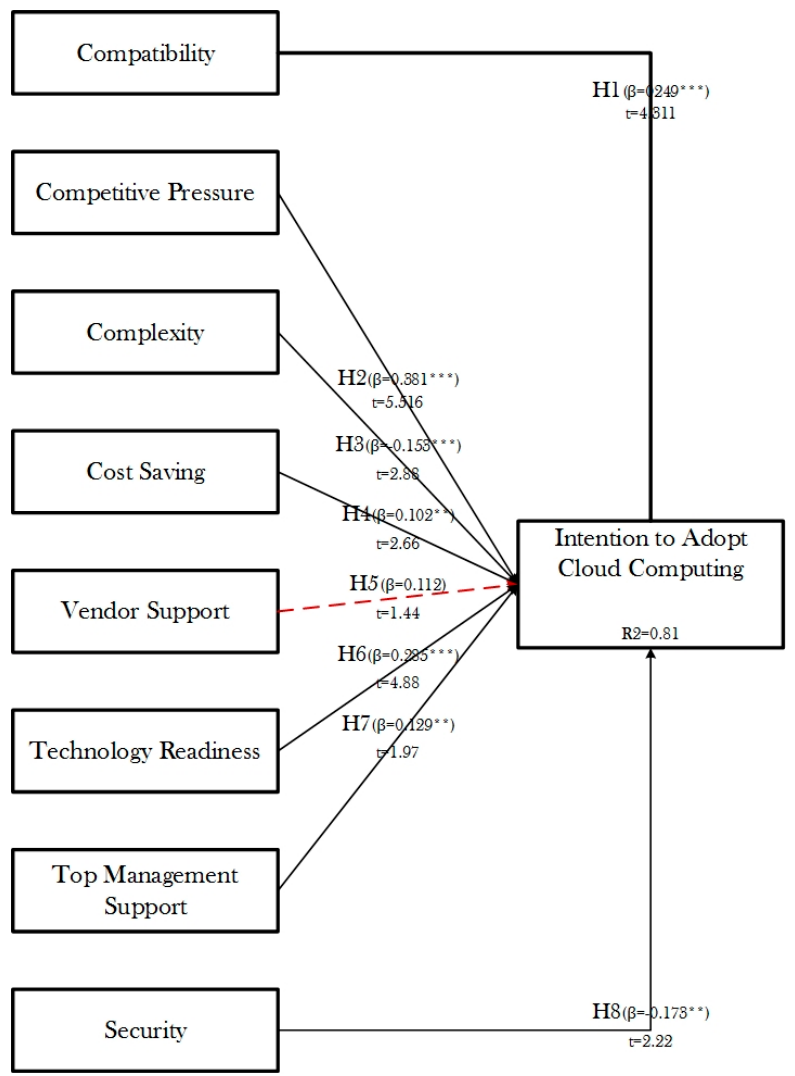
Figure 2. Results of structural model. Note: ** < 0.05, *** < 0.01.